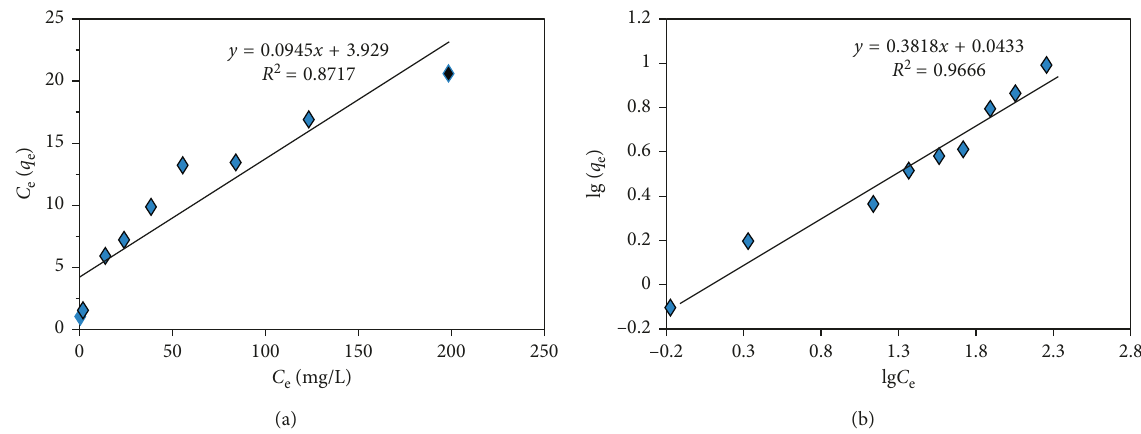
Figure 6: Adsorption isotherm of MB: (a) Langmuir isotherm and (b) Freundlich isotherm. Table 1: Kinetic parameter and correlation coefficient of two ki- netic equations. Langmuir